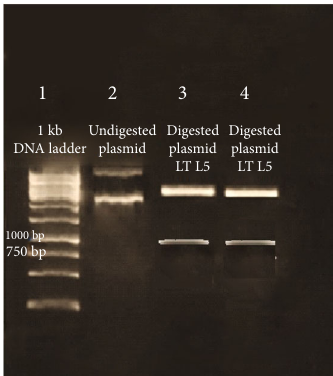
Figure 3: 1% agarose gel electrophoresis stained with ethidium bromide of the extracted, double-digested plasmid. Lane 1: DNA ladder 1kb. Lane 2: undigested plasmid band. Lanes 3 and 4: digested plasmid shows a band of the ribosomal protein L5 gene and a band of the